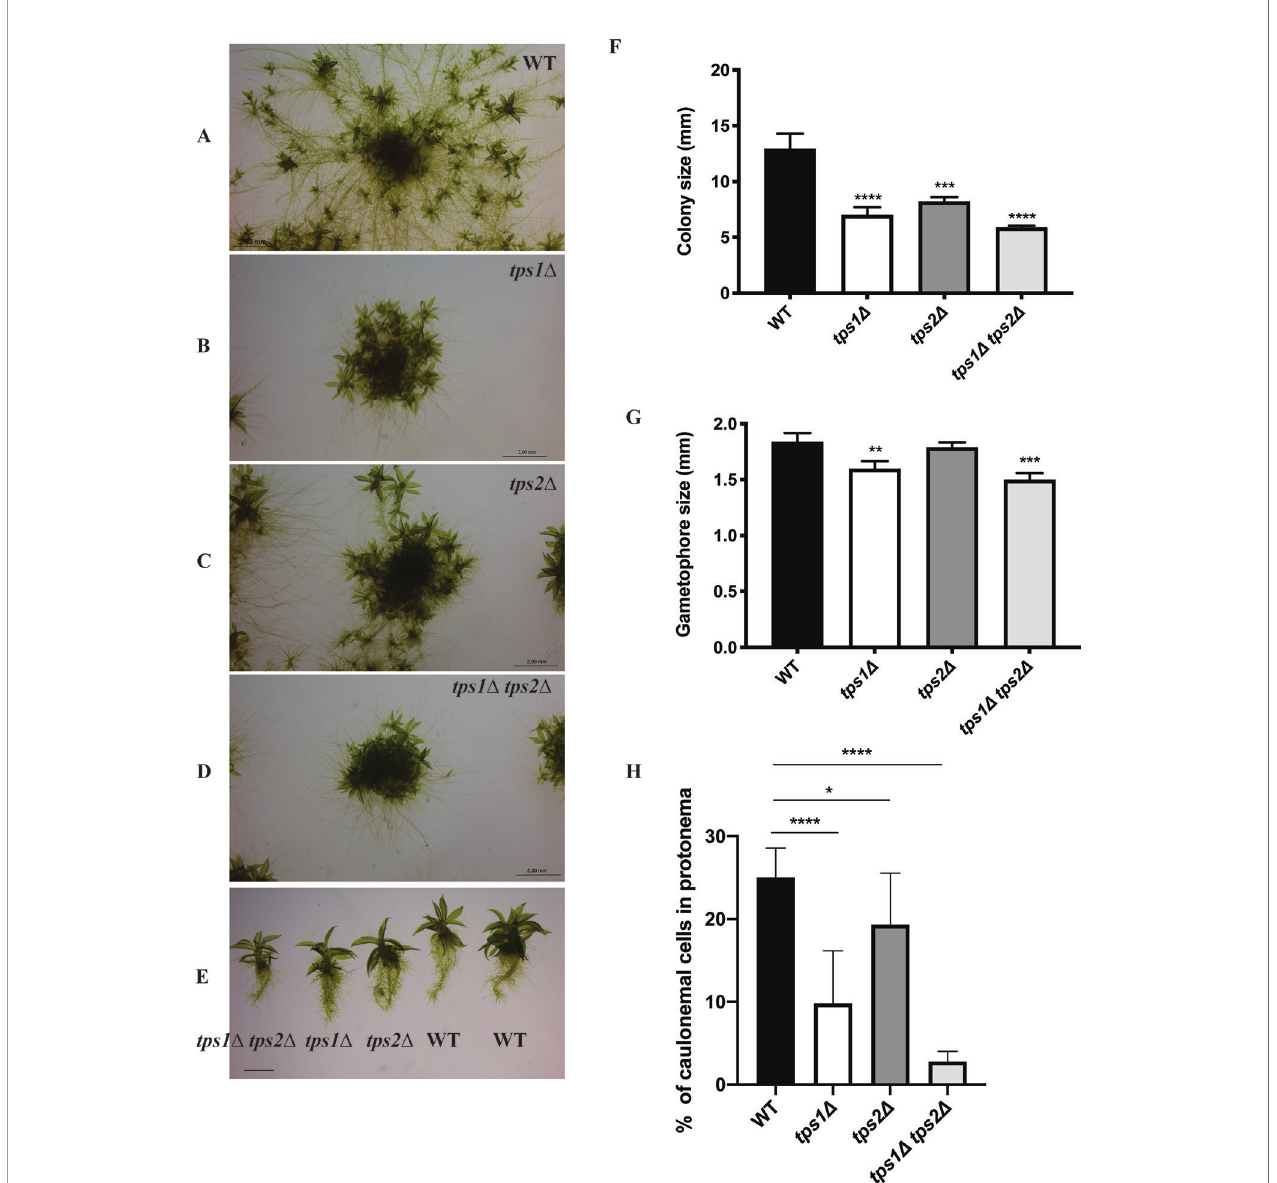
FIGURE 7 | Morphology of protonema of wild-type (WT) and transgenic plants. (A – E) Representative images of protonema morphology of WT and knockout lines grown on BCDAT medium in continuous light at 25°C for 1 month. Bars represent 2 mm. Measurement of colony size (F) and gametophore size (G) of WT and transgenic plants. Data represent mean ± SD of three individuals of protonema colonies or gametophores. (H) The percentage of caulonemal cells in protonema colonies of WT and mutant lines. Thirteen protonema colonies of each line were selected randomly to count the numbers of caulonemal cells. Statistical analysis with one-way ANOVA, *p ≤ 0.05, **p ≤ 0.01, ***p ≤ 0.001, ****p ≤